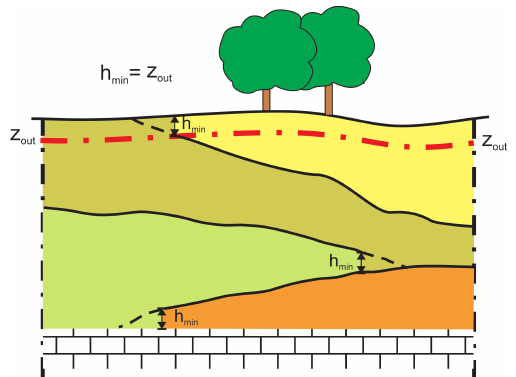
Figure 3. Example of the thicknesses cutting performed by mod2 of the